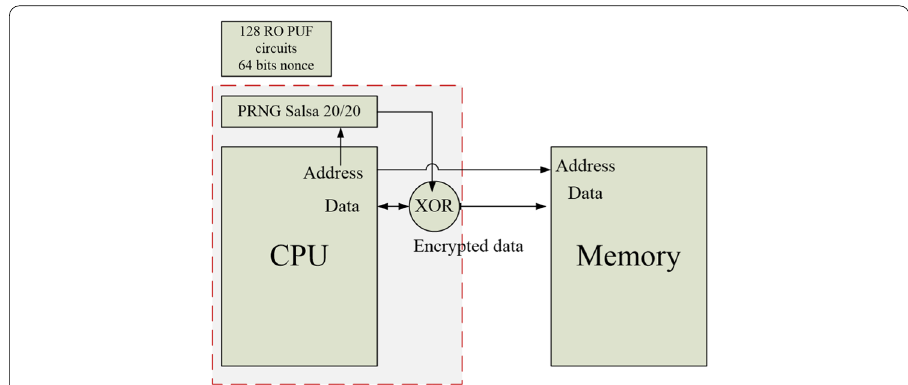
Fig. 4 Encryption Scheme between Microprocessor and System